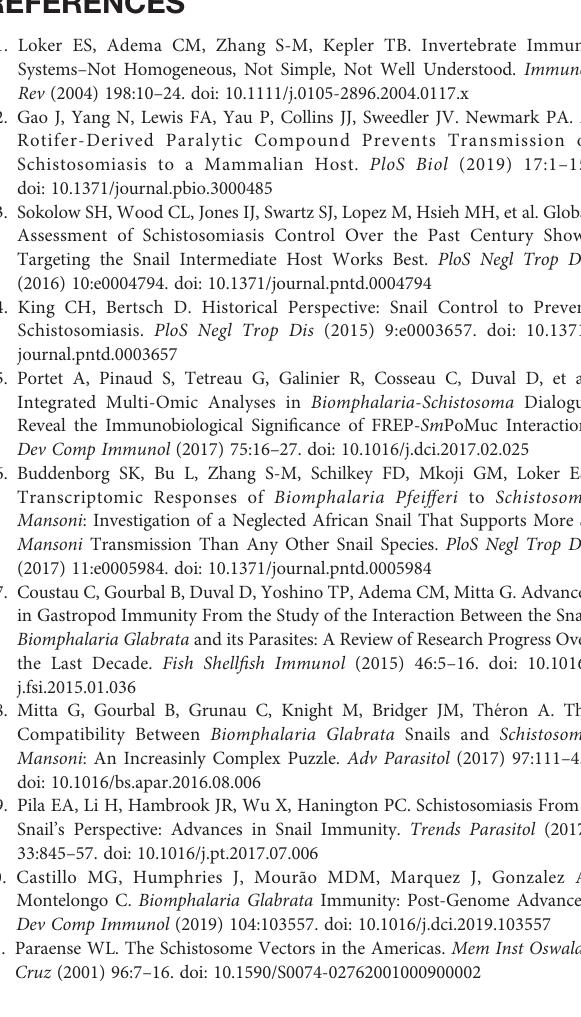
Supplementary Figure 1 | Bar graph of 3 Differential Expression (DE) methods comparison. Supplementary Figure 2 | Plot of 45 modules in RES strain for co-expression network analysis. Supplementary Figure 3 | Plot of 29 modules in SUS strain for co-expression network